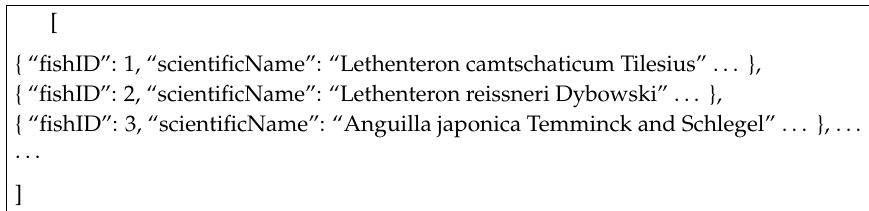
Algorithm 3. Representation for the Fish collection resource.